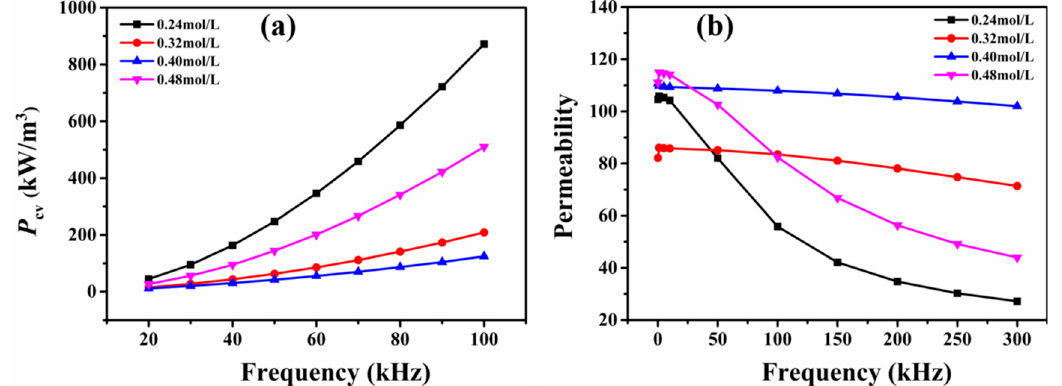
Figure 8. ( a ) Loss and ( b ) effective permeability of SMC rings made by the photodecomposition of coated iron powder with diethyl zinc solutions of different